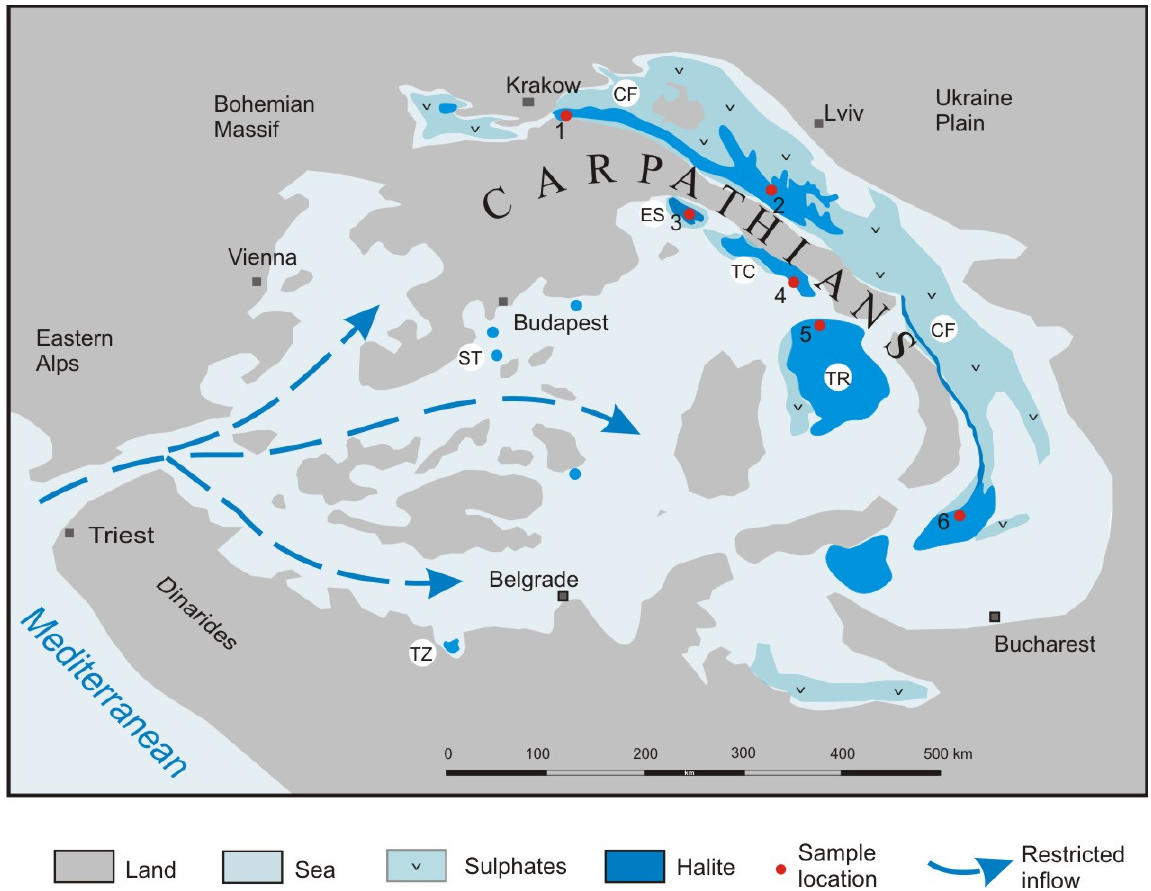
Figure 1. Paleogeographic map of sedimentation in the Badenian saline basins of the Central Paratethys, compiled after [25,26,28–31]. Locations of the investigated areas: 1—Wieliczka; 2—Hrynivka; 3—Zbudza; 4—Solotvyno; 5—Ocna Dej; 6—Sl ă nic-Prahova. Salt basins: C.F.—Carpathian Foredeep; E.S.—East Slovakian Basin; T.C.—Transcarpathian Basin; T.R.—Transylvanian Basin; S.T.—Soltvadkert Trough; T.Z.—Tuzla Basin. Blue circles—boreholes with evaporites in the Soltvadkert Trough, after [26]. Square, gray symbols—main cities.